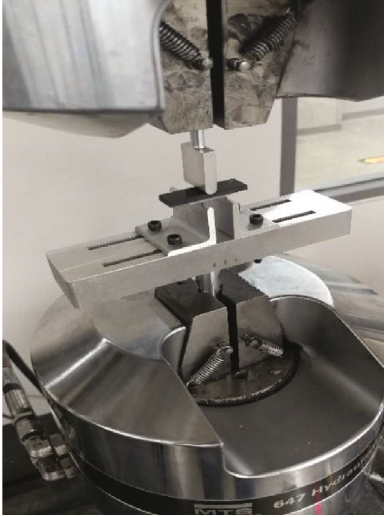
Figure 4: Short-beam test